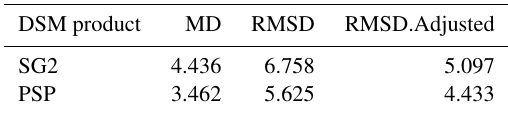
Table 6. The statistical differences between gSSURGO and DSM products for pH × 10 at 0–5cm. The centre of the map is at − 76 ◦ 30 (cid:48) 30 (cid:48)(cid:48) E, 42 ◦ 52 (cid:48) 30 (cid:48)(cid:48) N. DSM product MD RMSD